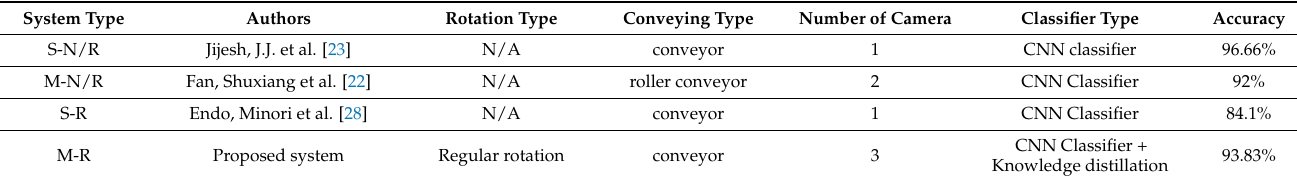
Table 10. Performance comparison with systems based on CNN